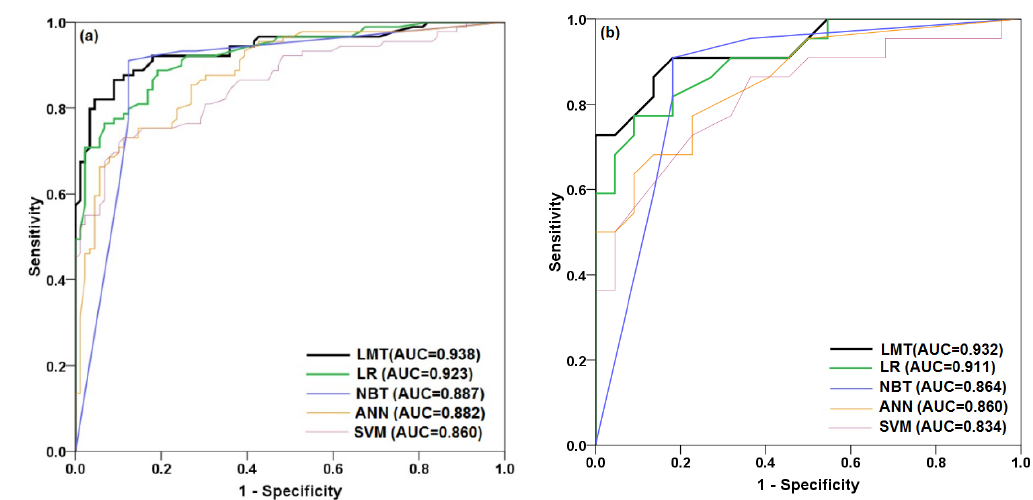
Figure 8. Receiver operating characteristic (ROC) curves and area under the receiver operatic characteristic curve (AUC) for the ( a ) training dataset and ( b ) validation dataset.